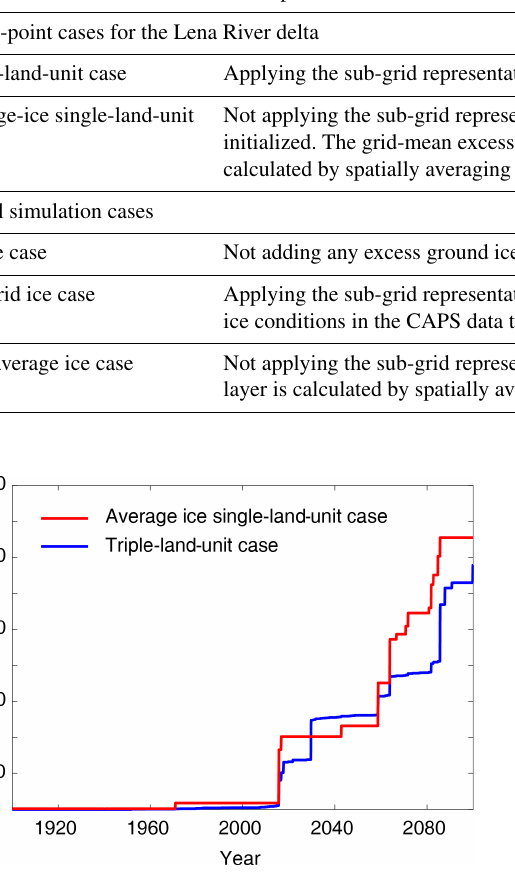
Figure 5. Grid-mean excess-ice melt since 1900 for the single- point cases over the Lena River delta with and without the sub-grid excess-ice